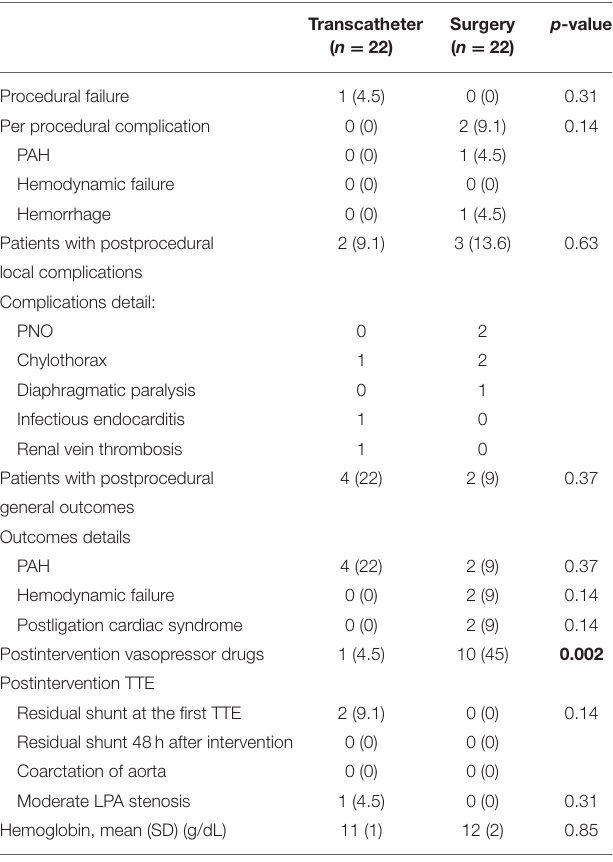
TABLE 3 | Operative and postoperative